Question: Which kind of chart has been used to present this data?
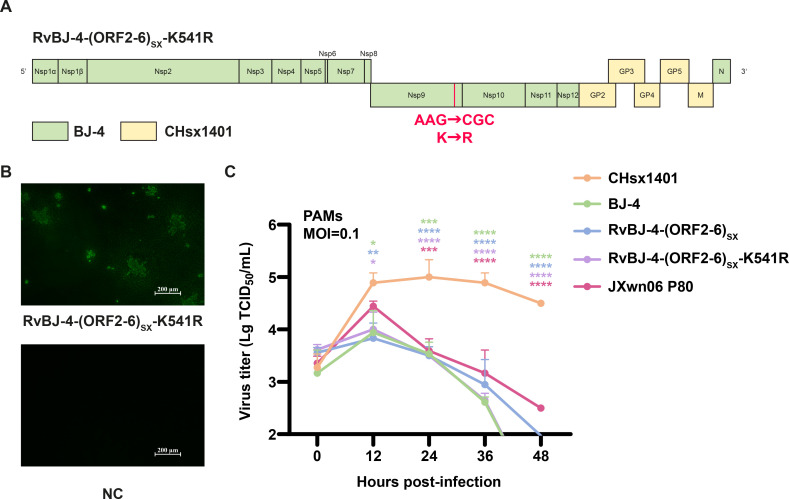
Answer: line